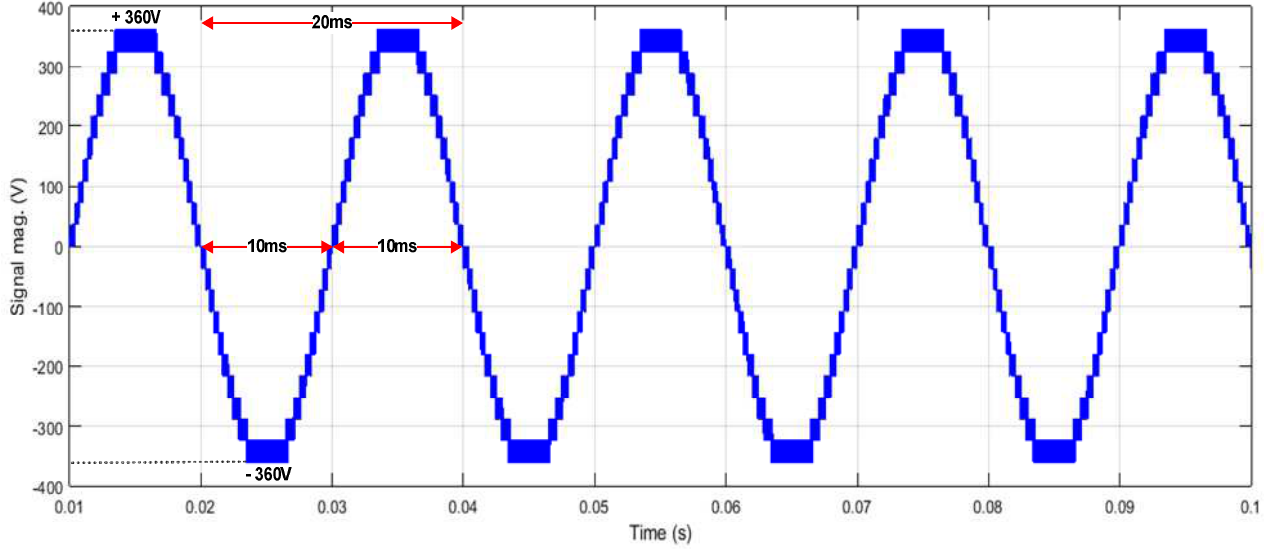
Figure 25. Continuous stepped sine-wave output voltage of a 21-level multilevel inverter using the SPWM digital switching controller with a carrier frequency of 20 kHz.